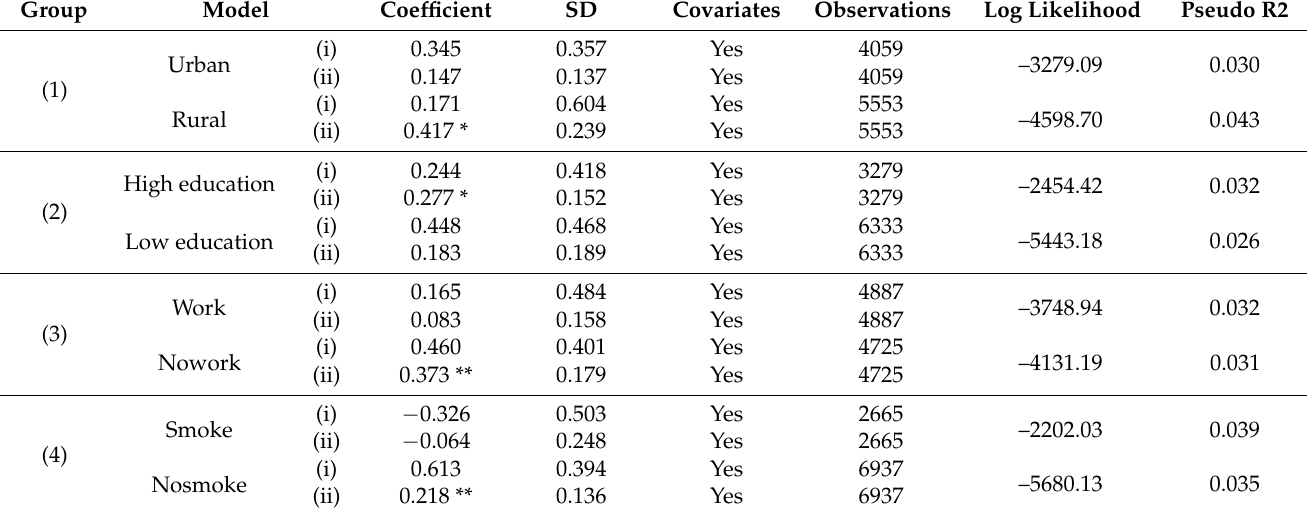
Table 4. Regression results of heterogeneity analysis of the effect of indoor air purification on residents’ self-rated health based on the generalized ordinal logit